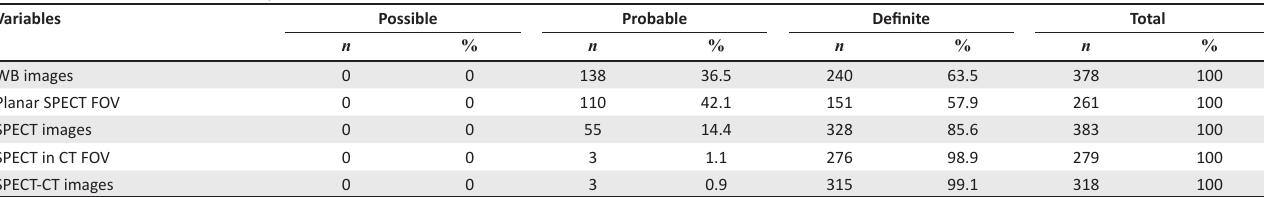
TABLE 3: Lesion localisation certainty. Variables